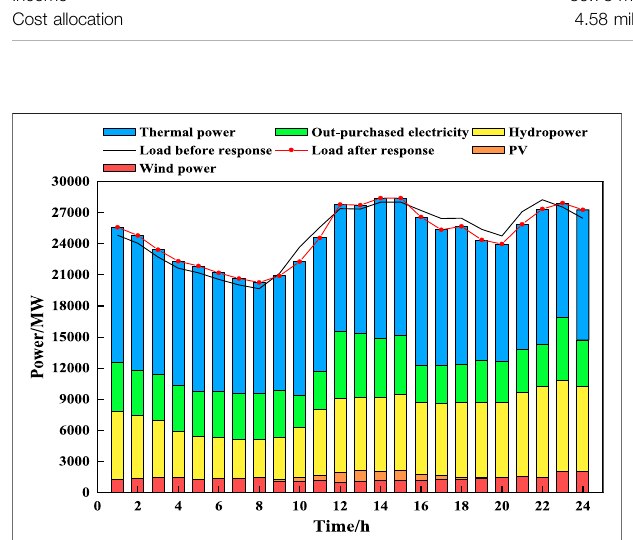
FIGURE 5 | Output diagram of various units after optimization.